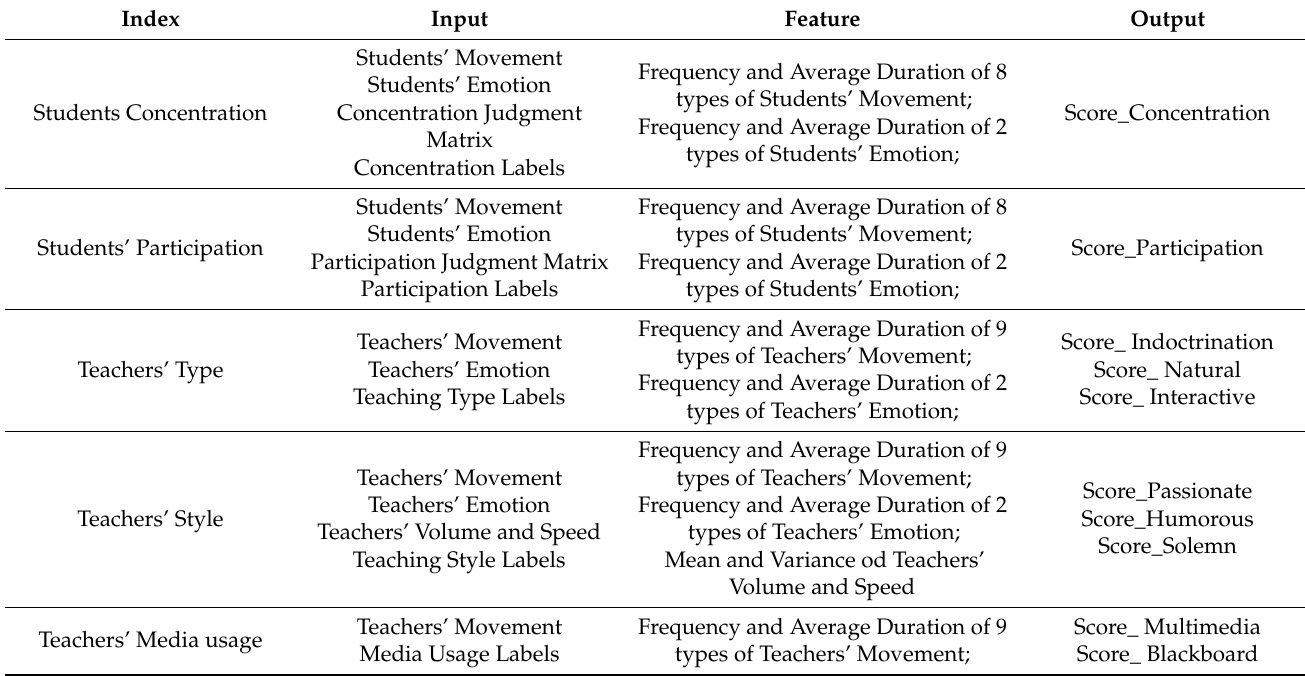
Table 1. The calculation of indicators in the statistical modeling